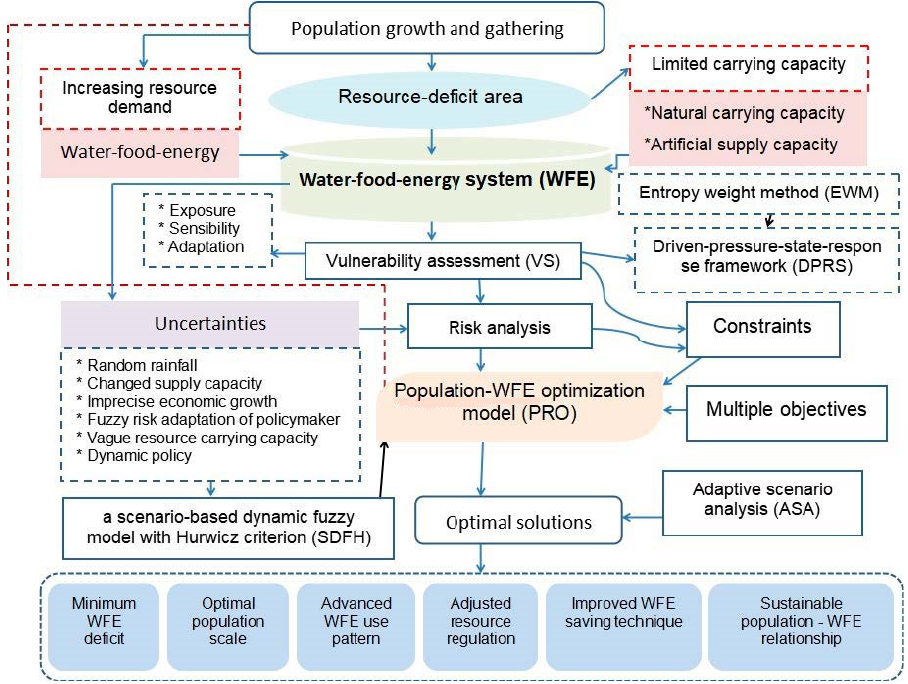
Figure 1. An adaptive population—resources management framework (APRF) under combined policies and its application in Beijing.